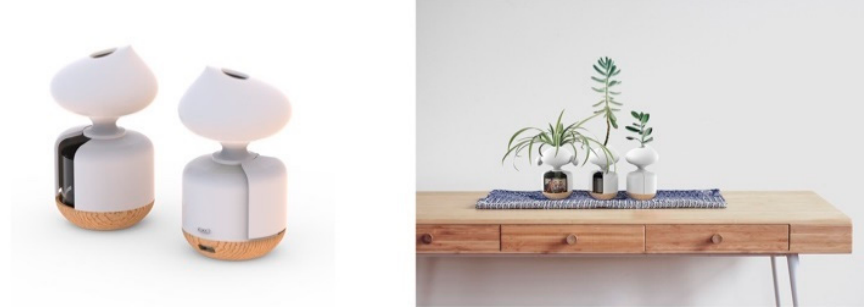
Figure 1. RECALL (The name of intelligent vase which defined by this paper) product effect display.